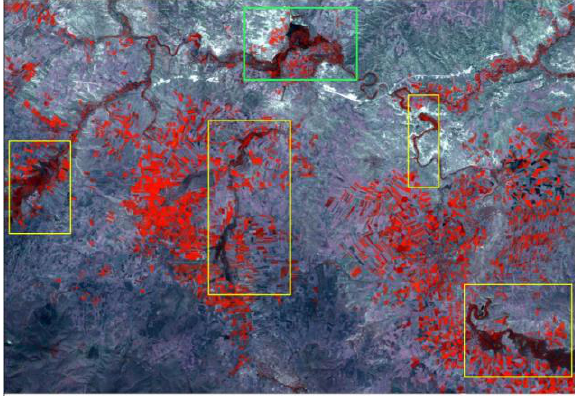
Figure 1. Sentinel-2 image of the study area (RGB – 8a, 4